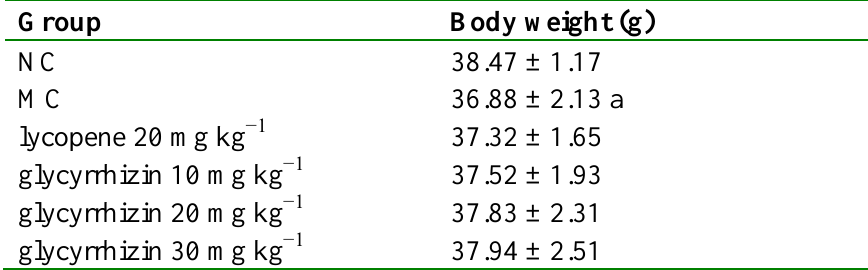
Table 1. Body weight in different groups.